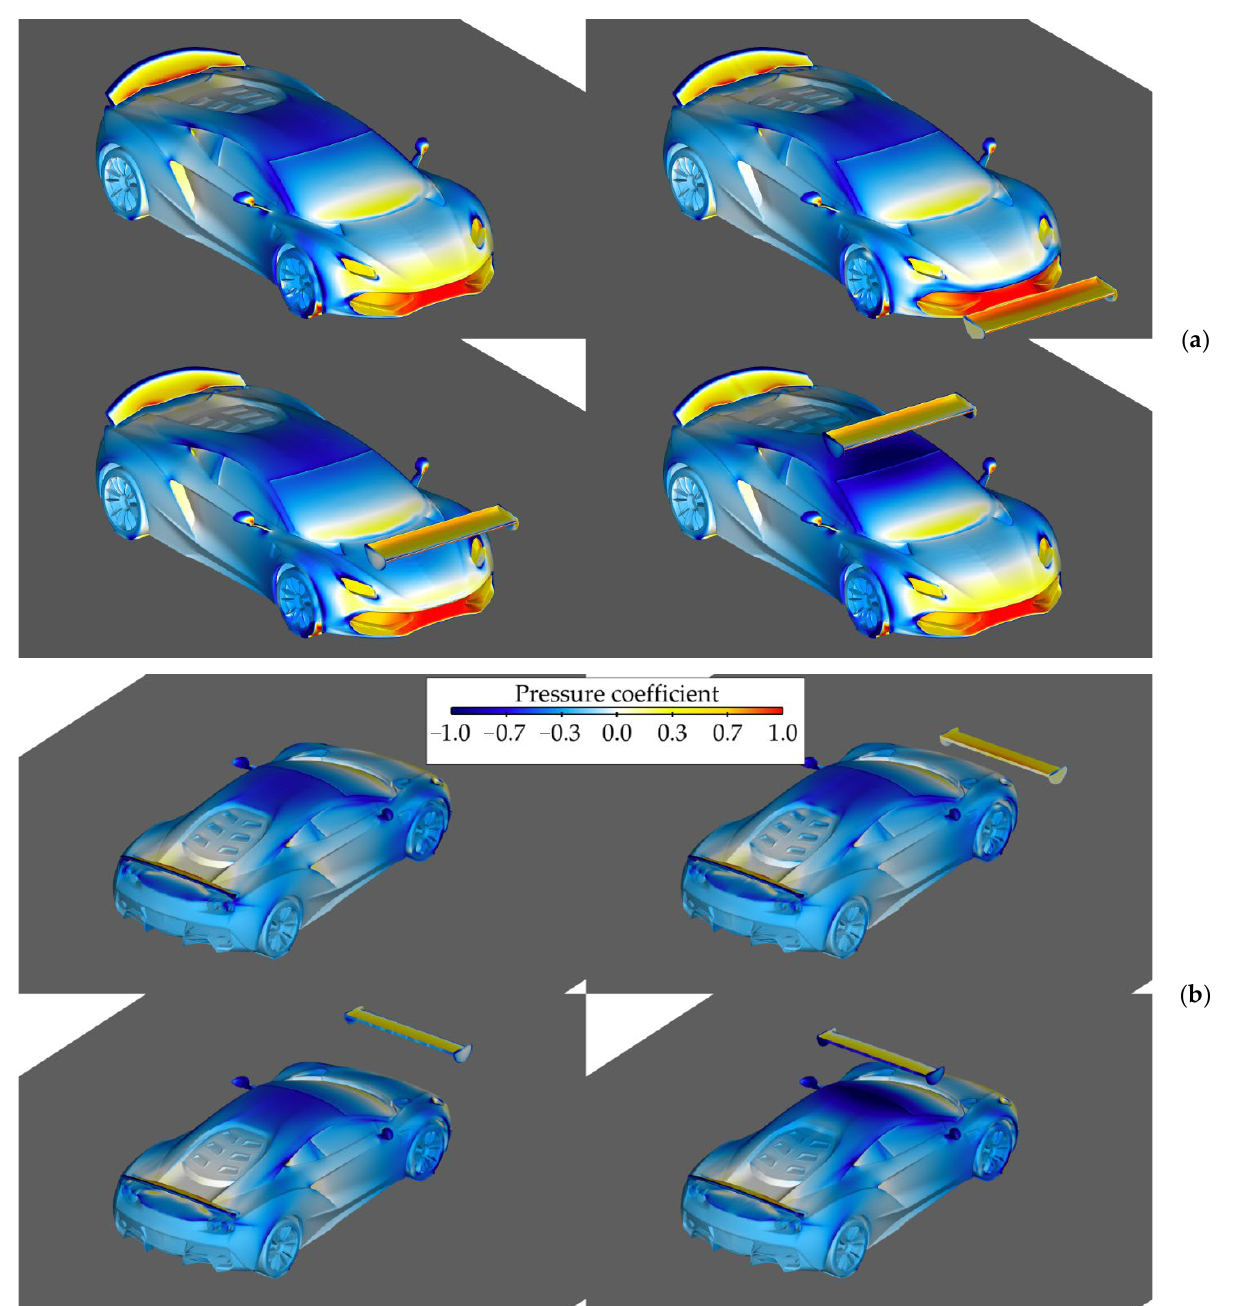
Figure 32. Pressure distributions on the symmetry plane for a vehicle without a front wing and a vehicle with three different wing positions (side view).